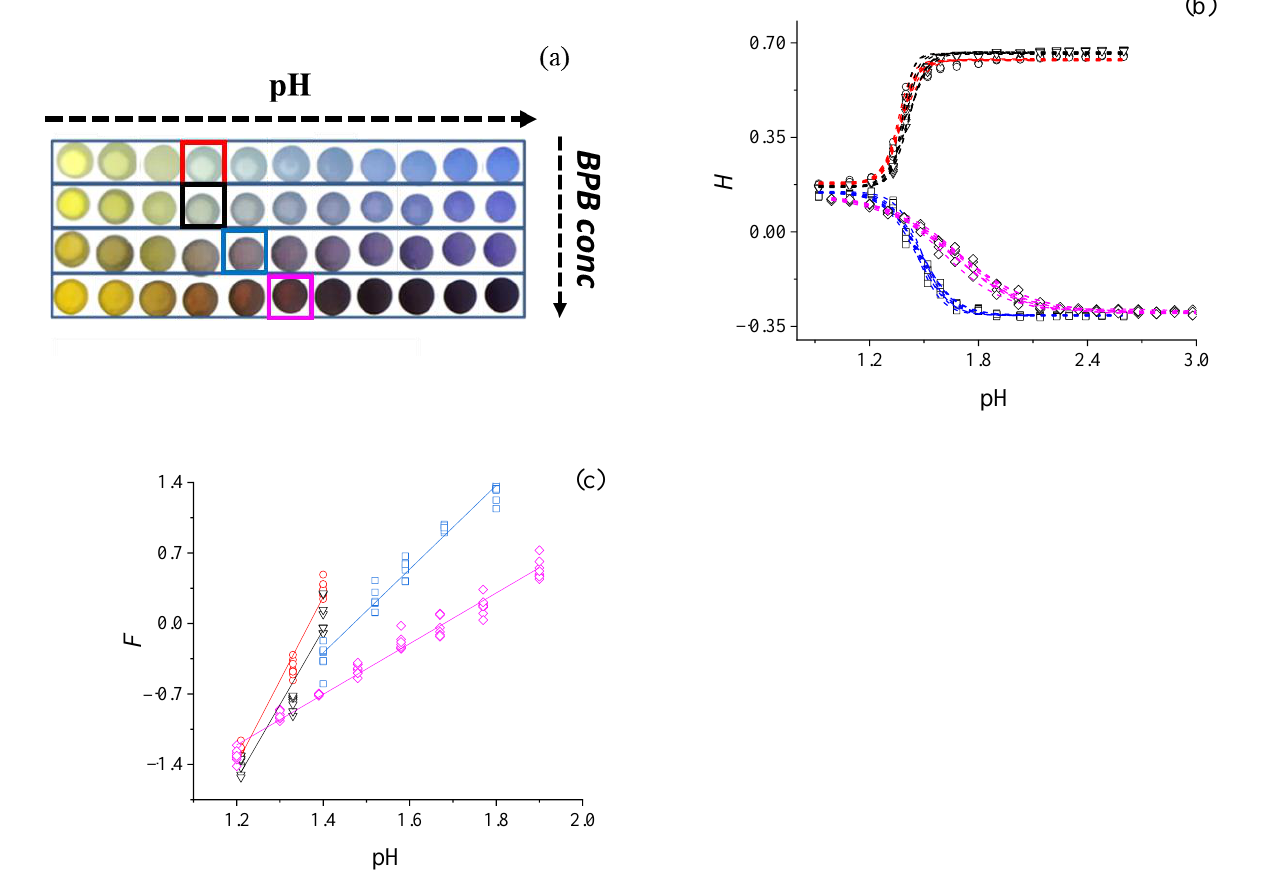
Figure 6. ( a ) CSA vs. pH and BPB concentration. Only one spot was reported for each BPB concentration, at 11 pH values. The squares highlight the color variation from green to brown near 𝑝𝐾 𝐴 . ( b ) H profiles vs. pH of the CSAs prepared with solutions with increasing BPB concentration (8 repeated spots for each concentration): 1 (red curve; ○ ); 2 (black curve; ▽ ); 3 (blue curve; □); 4 (purple curve; ◊) of section 2.2. ( c ) Corresponding linearization profile F of ( a ) vs. pH. The regression variance was estimated by using 8 sensors for a total of 32 spots. Their